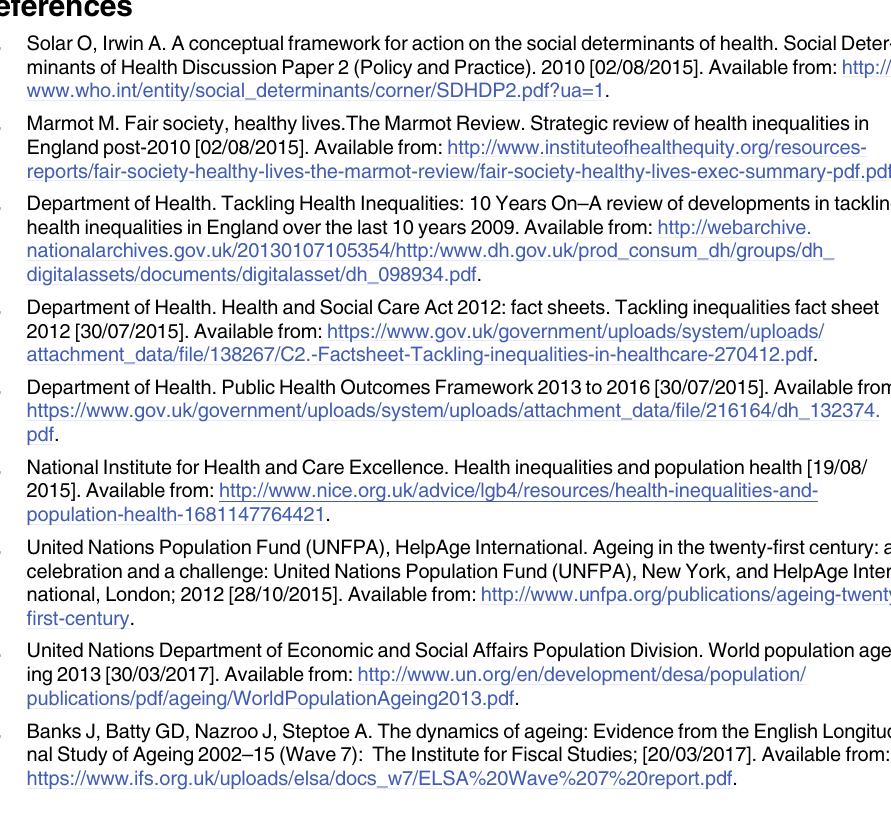
S3 Fig. Proportion of total study population (n = 591037) with recording of time varying social factors within 5 years of index date